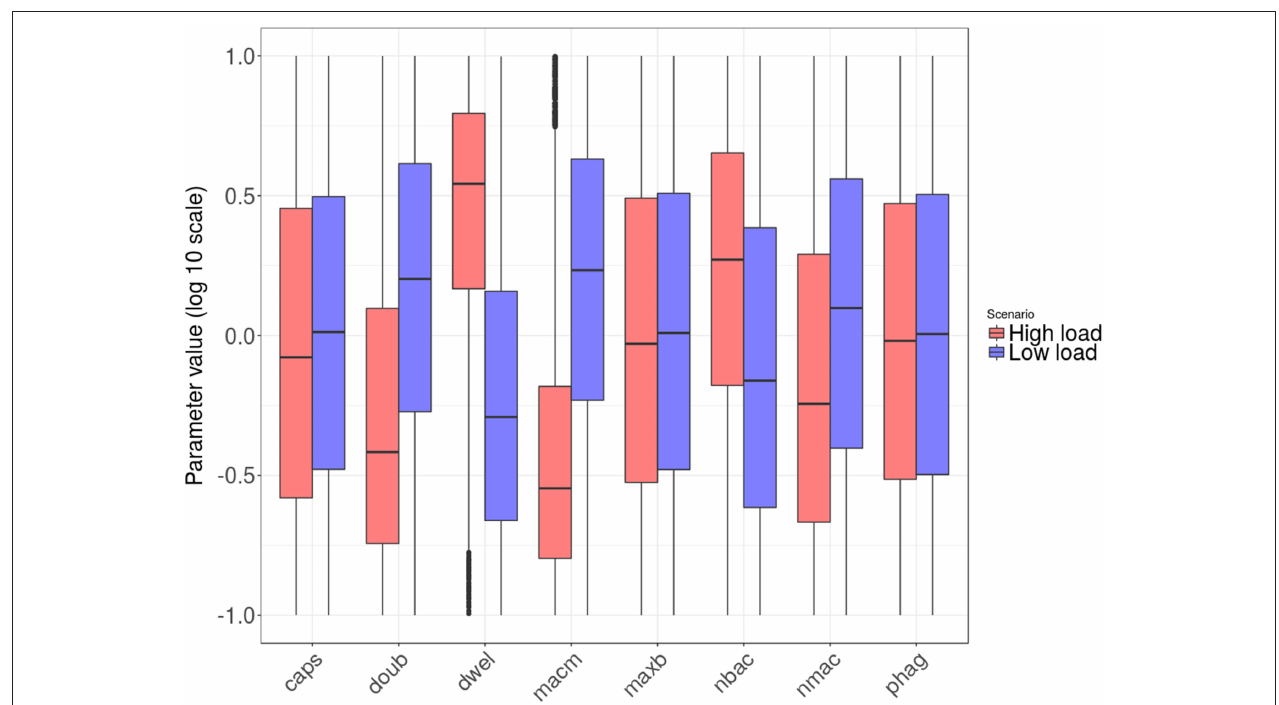
FIGURE 5 | Box plots of tissue-level parameter value distributions in the two groups: high load group in red and low load in blue. Only the parameters revealing significant differences according to the logistic regression analysis are shown.